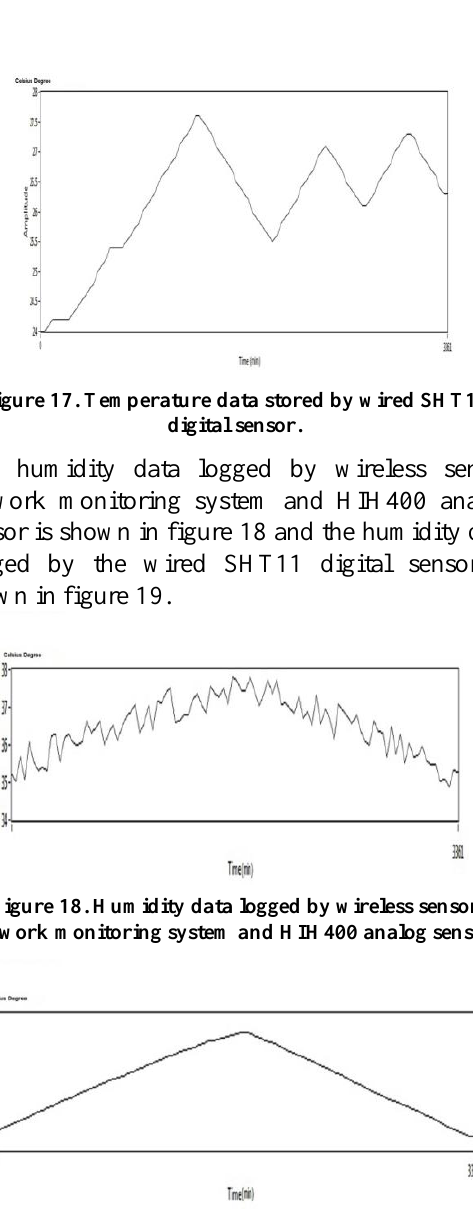
Figure 19. Humidity data logged by wired SHT11 digital